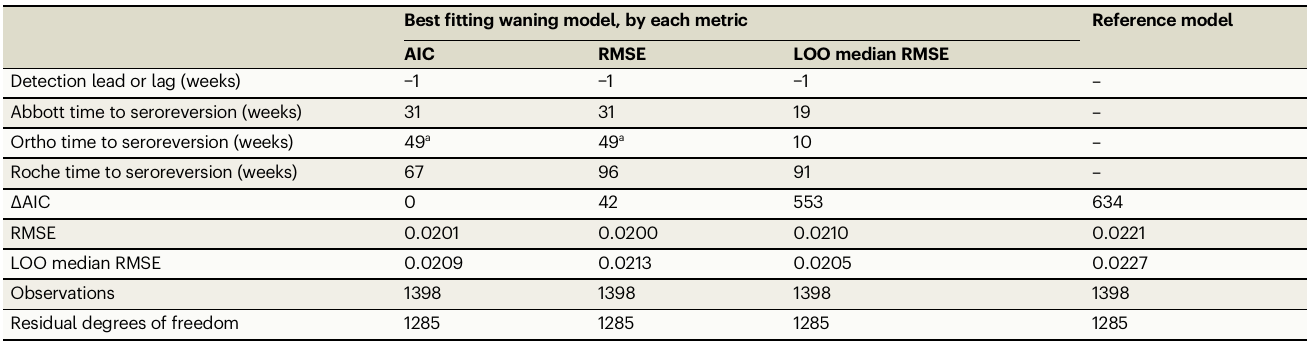
Table 1 | Best waning models across three metrics, compared to the reference model Best fi tting waning model, by each metric Reference